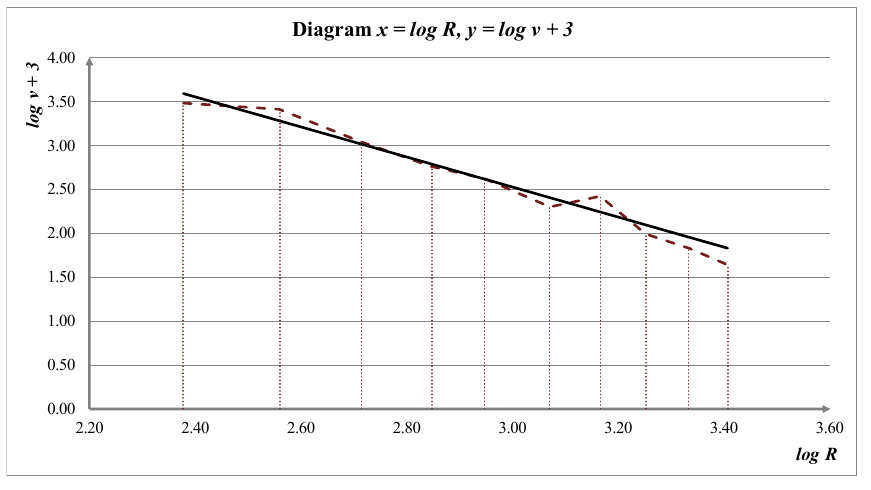
Figure 3. Graphic representation of values logR and logv + 3 for calculating the parameters in Majdanpek open pit